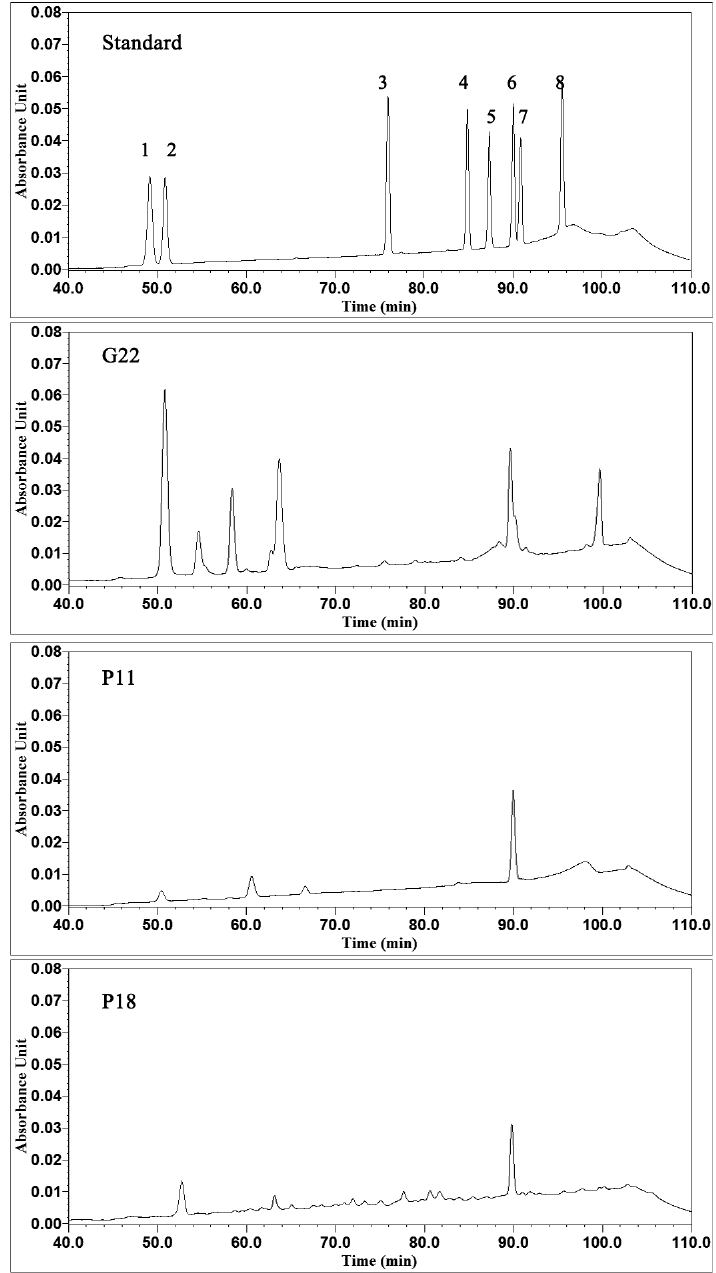
Figure 2. High-performance liquid chromatography (HPLC) spectra of the ginsenoside standards and the culture filtrates of the representative strains. 1, Rg1; 2, Re; 3, Rf; 4, Rb1; 5, Rc; 6, Rb2; 7, Rb3; 8,